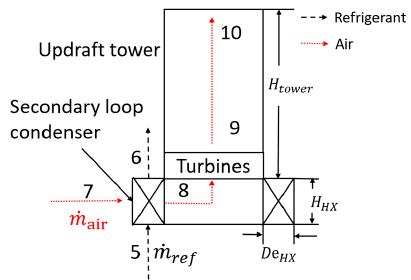
Figure 4. Schematic diagram and key geometric parameters of the updraft tower.